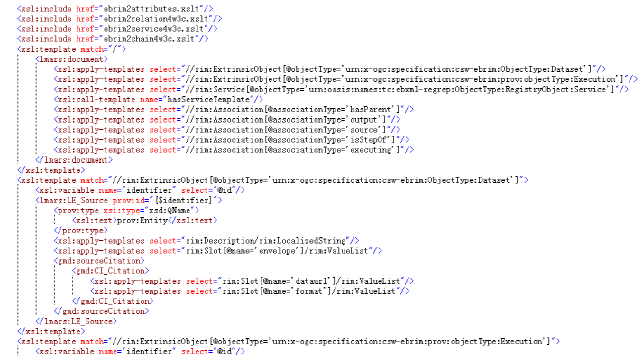
Figure 5. Fragment of XSLT style sheet